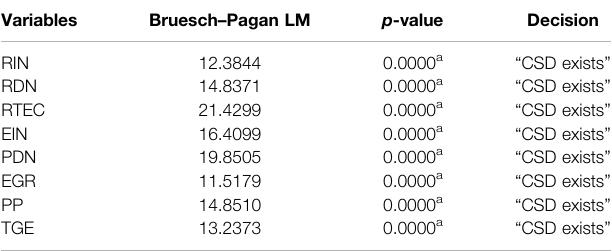
TABLE 4 | Cross-sectional dependency (CSD).